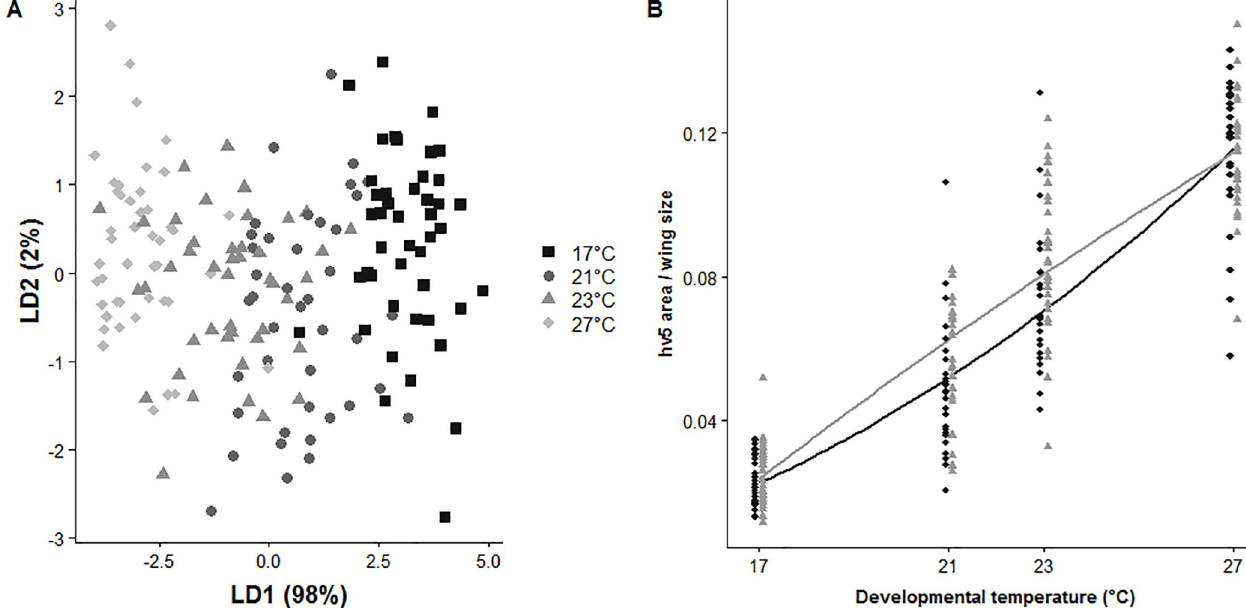
Fig 3. Characterization of the most polyphenic traits. (A) The first two Linear Discriminants (LD1 and LD2) from the Linear Discriminant Analysis of the polyphenic, wing morphological traits (hv5, hv2, and fv2 areas, and jct, each divided by wing size) and the visual sexually-selected traits (fd5 area divided by wing size and fd5 relative brightness) in both sexes across developmental temperatures (square: 17˚C, disk: 21˚C, triangle: 23˚C, diamond: 27˚C combined with decreasing darkness). (B) Area of hv5 eyespots divided by wing size (mm 2 ) for both sexes (males in grey triangle and females in black diamonds) across developmental